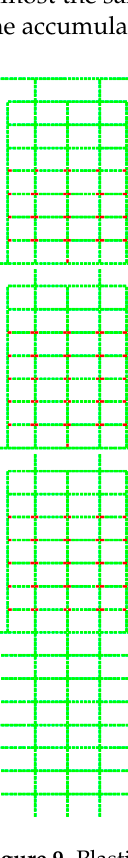
Figure 9. Plastic hinges formed under GM06 at the PGA of 0.83 g. Table 3. Failure path under GM06 at the PGA of 0.83 g.